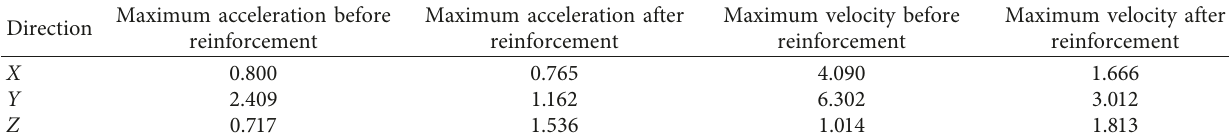
Table 4: Comparison of maximum acceleration and maximum velocity before and after reinforcement. Maximum acceleration before Maximum acceleration Direction reinforcement